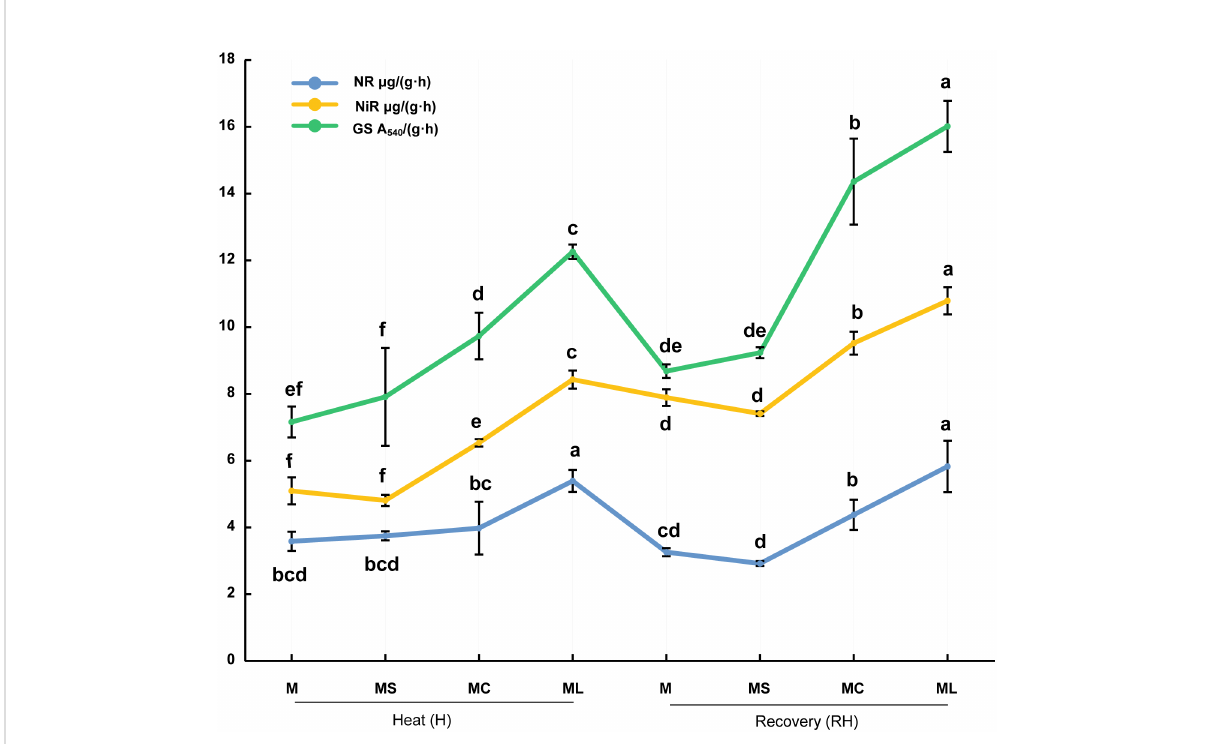
FIGURE 6 Activity of nitrogen metabolism enzymes. Values are the mean (± SE) of three replicates. Different letters indicate statistically signi fi cant differences between the treatment groups ( P<